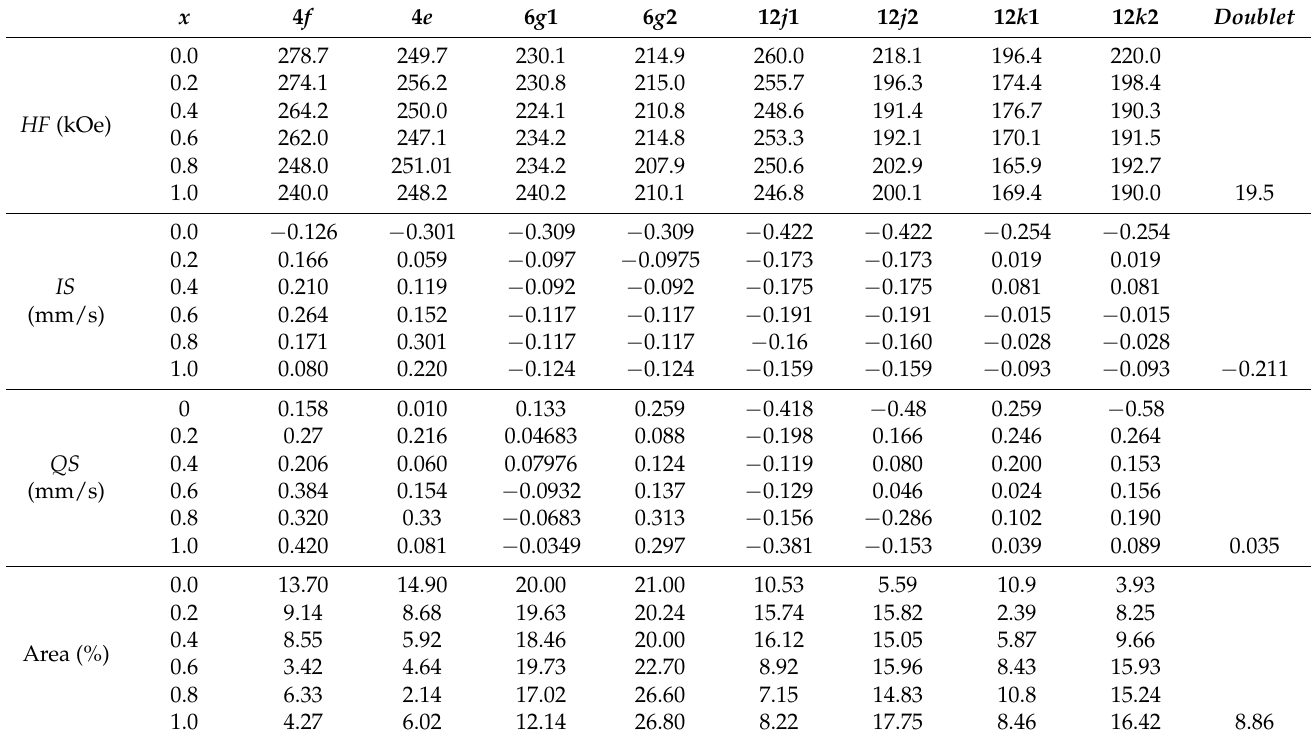
Table 2. The RT hyperfine parameters, hyperfine field ( HF ) (kOe), isomer shift ( IS ) (mm/s), quadrupole shift ( QS ) (mm/s), and area (%) of the Dy2Fe16Ga1 − x Nb x .